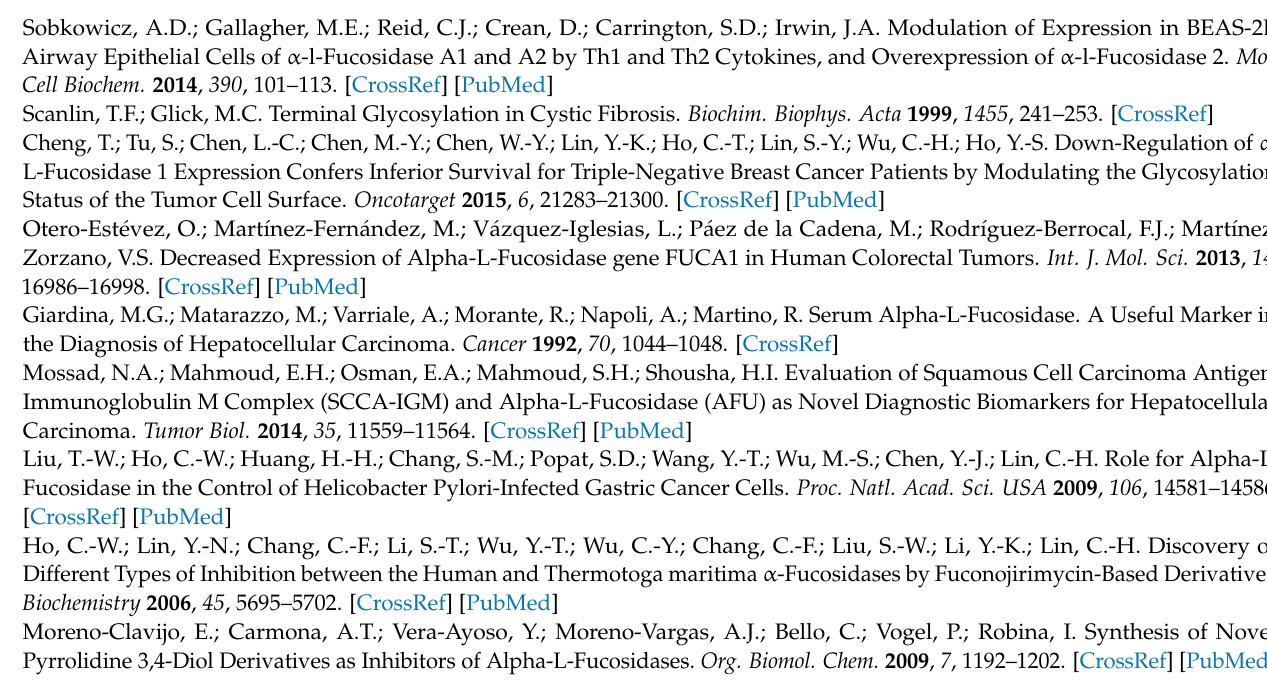
C NMR of compound 10 , Figure S4: HRMS of compound 10 , Figure S5: Semipreparative HPLC chromatogram of [ 11 C]3 from GE FX